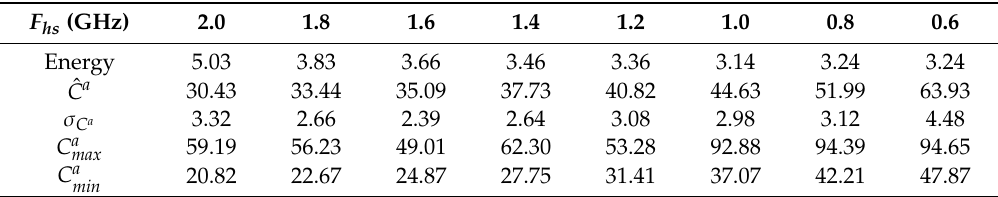
Table 11. Interactive governor with conf2 and different F hs values. Vid1.